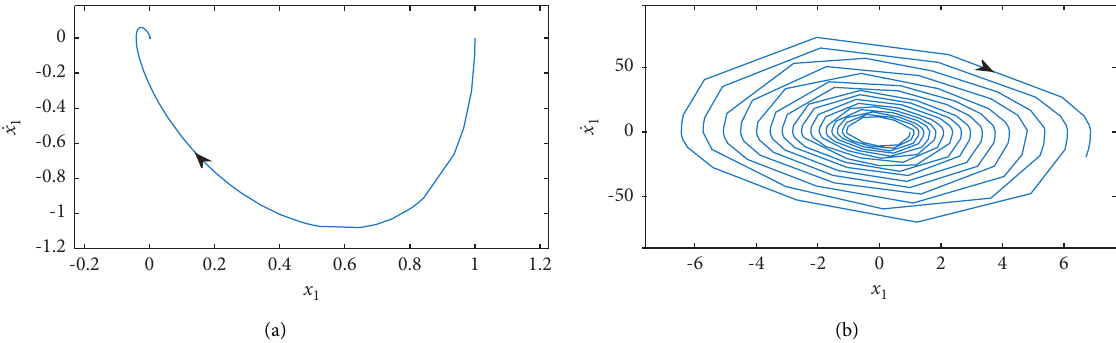
Figure 4: The phase portrait of a 1-DOF systems with different nonlinearities in the feedback path. (a) The phase trajectory of state x the selected ω in the stable range. (b) The phase trajectory of state x 1 s